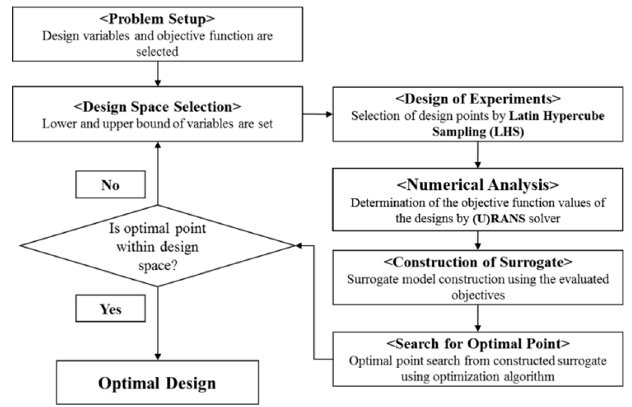
Figure 4. Optimization procedure.